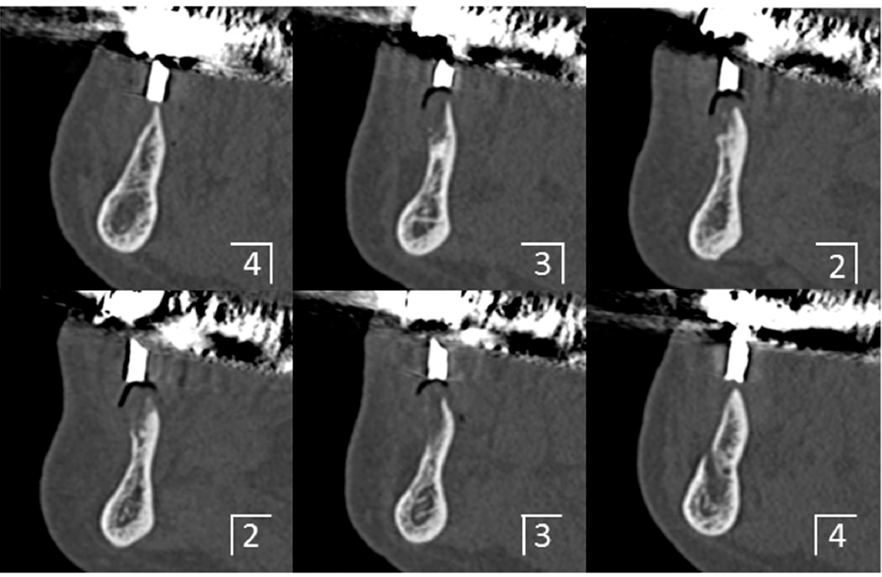
Figure 3. Preoperative computer tomograpy images taken in placing the diagnostic denture. Cross-sectional images at each position.